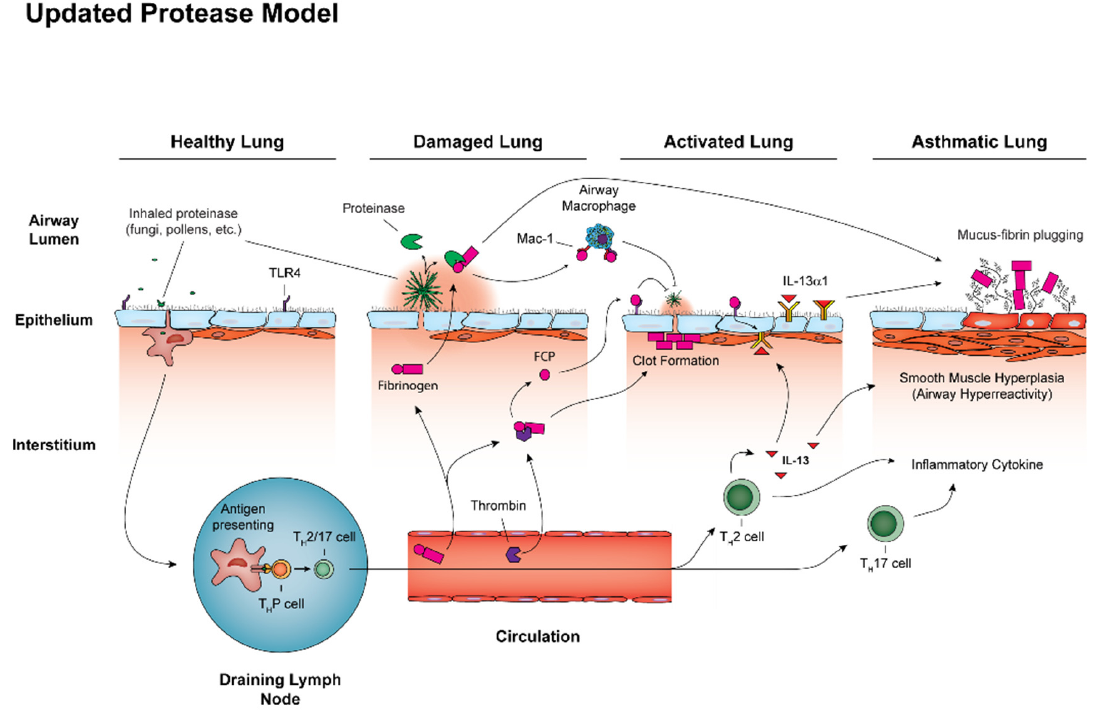
Figure 1. Airway mycosis coordinates activation of the airway type 2 immune response in allergic airway disease. All persons are exposed to inhaled irritants such as pollens, but also infectious agents such as fungal spores. These exposures may trigger innate and adaptive immune responses, including Th2 and Th17 cell activation, through antigen presentation by dendritic cells, but usually without inducing disease. Lungs can become damaged, however, should fungi gain a foothold within the airway lumen and begin producing proteinases. These enzymes cleave fibrinogen into fibrinogen cleavage products (FCP) that bind to the integrin Mac-1 and ultimately Toll like receptor 4 (TLR4) to activate innate antifungal immunity through macrophages and epithelial cells. With more advanced degrees of airway mycosis, potentially due to a failure of antifungal mechanisms, additional changes can occur to activate the lung, including FCP-dependent induction of chemokines to promote recruitment of allergic effector cells (e.g., Th2 cells, Th17 cells, eosinophils) to the airways and also upregulation of IL-13R α 1, the main binding chain of the IL-13 receptor. Allergic airway disease results from sustained lung activation due to fungal proteinases, resulting in attendant remodeling that